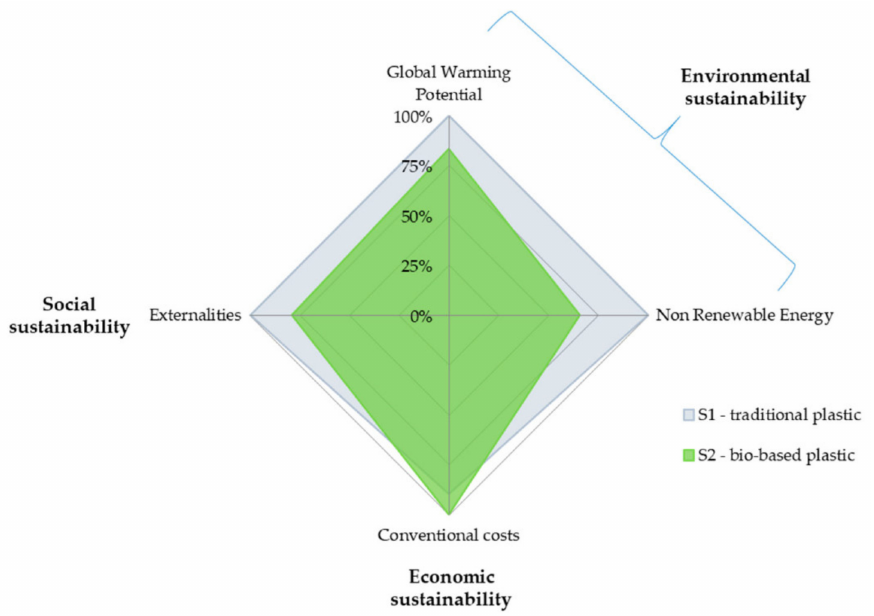
Figure 9. Sustainable performance results according to the triple bottom line (TBL) approach. Reprinted from